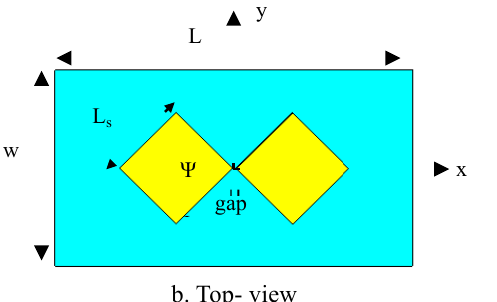
Figure 2. The detailed construction of rhombus shaped dipole IR-nanoantenna on a dielectric substrate with h=150 nm, w=5 µm, L=9 µm, L =5 µm, t=50 nm and gap=100 nm. s